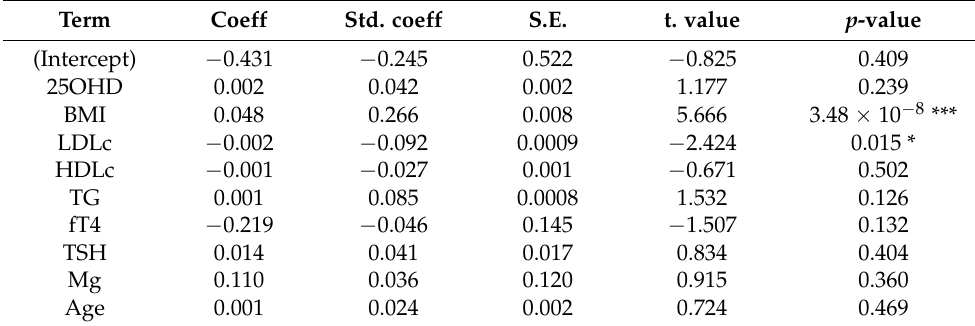
Table 5. A robust linear regression model describing the effects of 25OHD and several variables on HOMA-IR2 (insulin) in the study